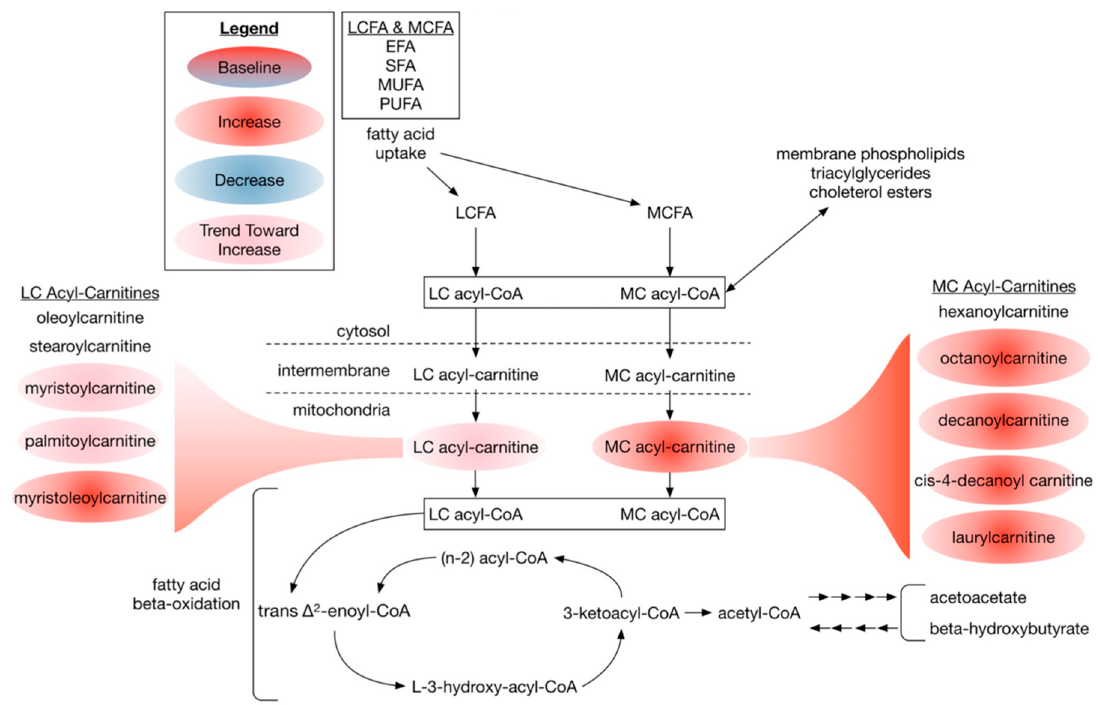
Figure 5. Changes in oxidation of fatty acids overlaid on a metabolic map. The size of each colored bubble is proportional to the fold change (increase, red; decrease, blue). The baseline bubble in the legend corresponds to a fold change of 1. C Acyl-Carnitines, Long Chain Acetyl-Carnitine; LCFA, Long Chain Fatty Acids; MCFA, Medium Chain Fatty Acids; EFA, Essential Fatty Acids; MUFA, Monounsaturated Fatty Acids; PUFA, Polyunsaturated Fatty Acids; LC acyl-CoA, Long Chain acetyl-coenzyme A; MC acyl-CoA, Medium Chain acetyl-coenzyme A; MC acyl-carnitine, Medium Chain acetyl-carnitine. Table 6. Metabolites of fatty acid oxidation.